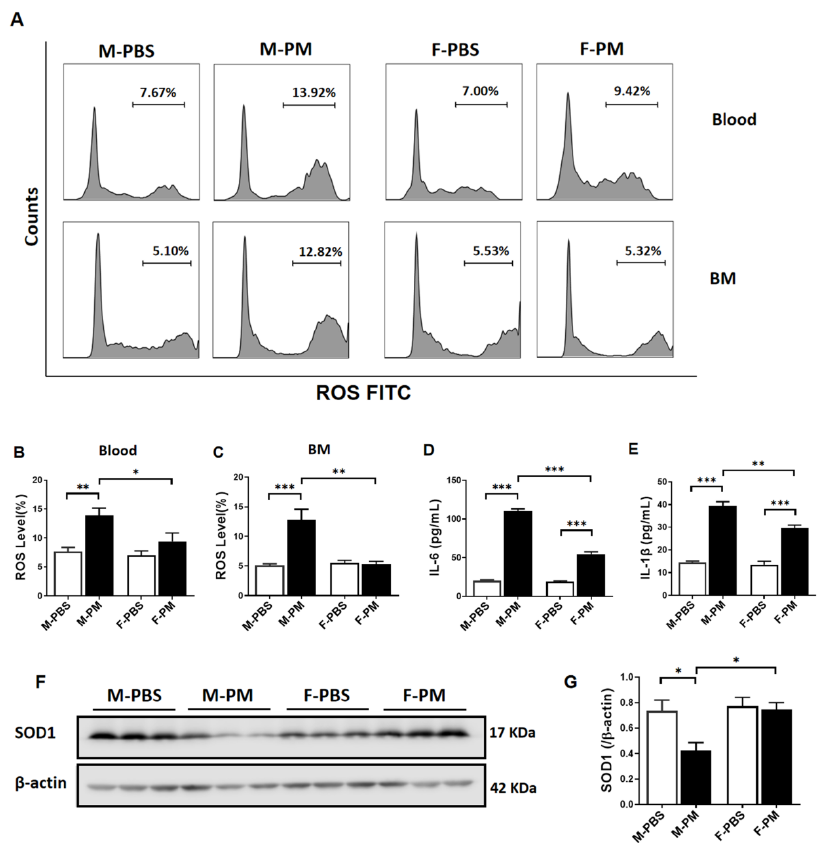
Figure 2. PM exposure decreased lung SOD1 expression with increased serum cytokines and intracellular ROS production . ( A ) ROS production in CD34 + /CD133 + cells was analyzed using flow cytometry, with summary data showing a significant increase in intracellular ROS production in male mice with PM exposure compared to the control group and female mice with PM exposure in blood ( B ) and bone marrow ( C ) ( n = 6). Serum IL-6 ( D ) and IL-1 β ( E ) were significantly increased in both male and female mice with PM exposure compared to the PBS control, while their concentrations in male mice were significantly higher than in female mice ( n = 5). ( F ) Protein expression of SOD1 in the lung, with summary data ( G ) showed significantly decreased SOD1 in male mice but not in female mice ( n = 3). The experiment was repeated three times independently. M-PBS: male mice with PBS treatment; M-PM: male mice with PM exposure; F-PBS: female mice with PBS treatment; F-PM: female mice with PM exposure. BM: bone marrow. * p < 0.05, ** p < 0.01 and *** p <